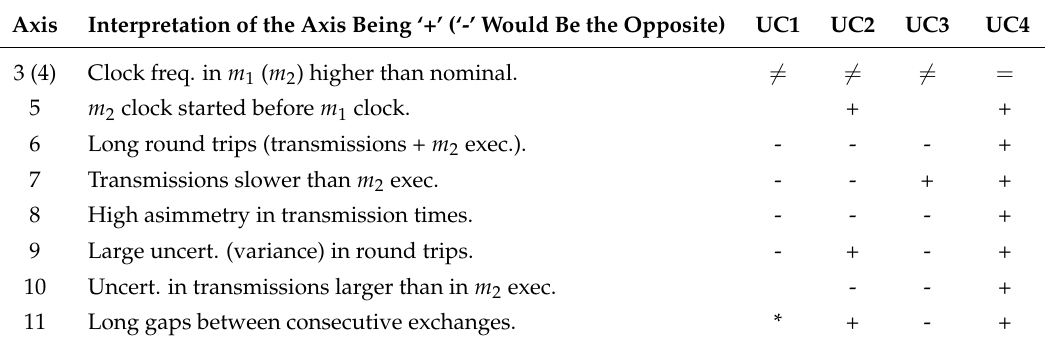
Table 8. Interpretation of axes and use cases of method selection. (cid:54) = stands for α R (cid:54) = 1, and = for α R =